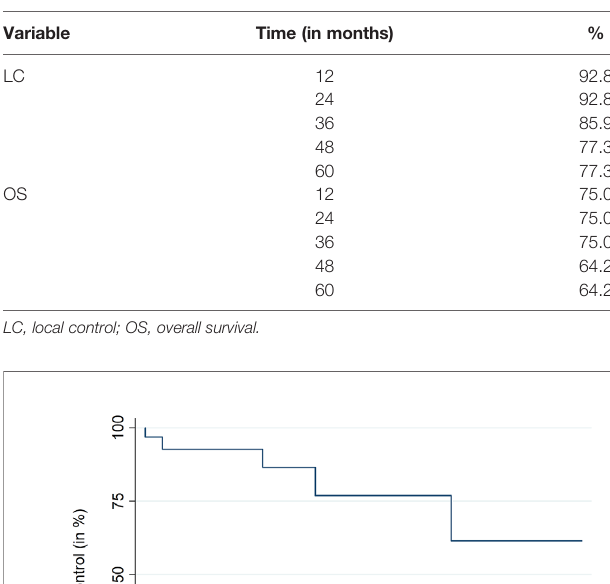
TABLE 2 | Local control and overall survival